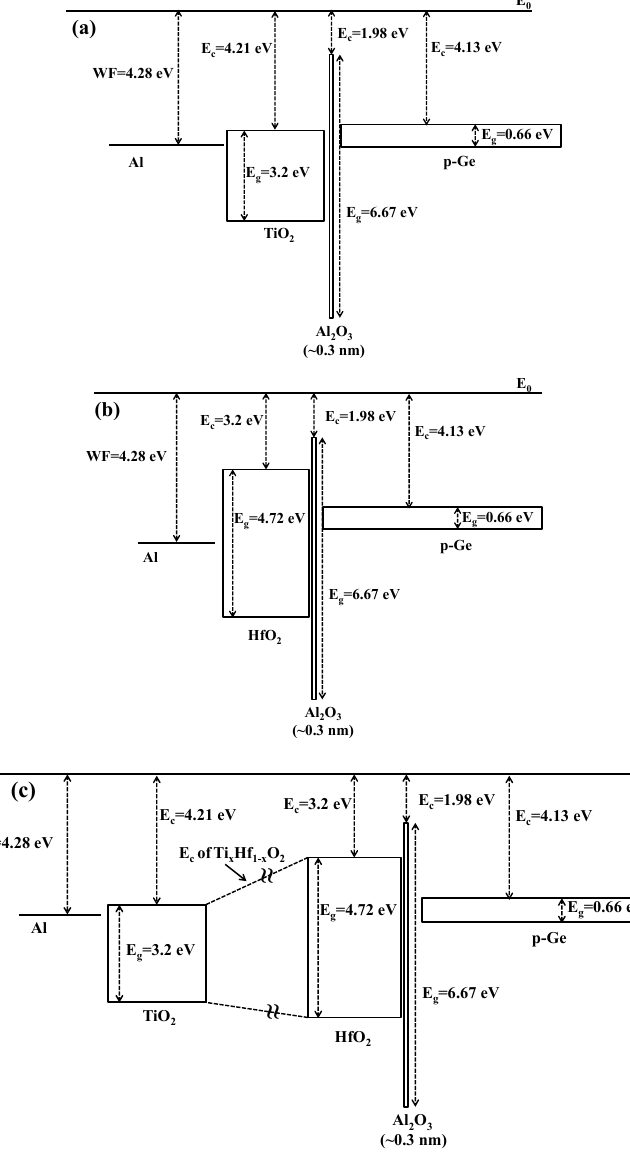
Figure 10. Energy band diagrams for: ( a ) titanium oxide; ( b ) hafnium oxide; and ( c ) titanium doped